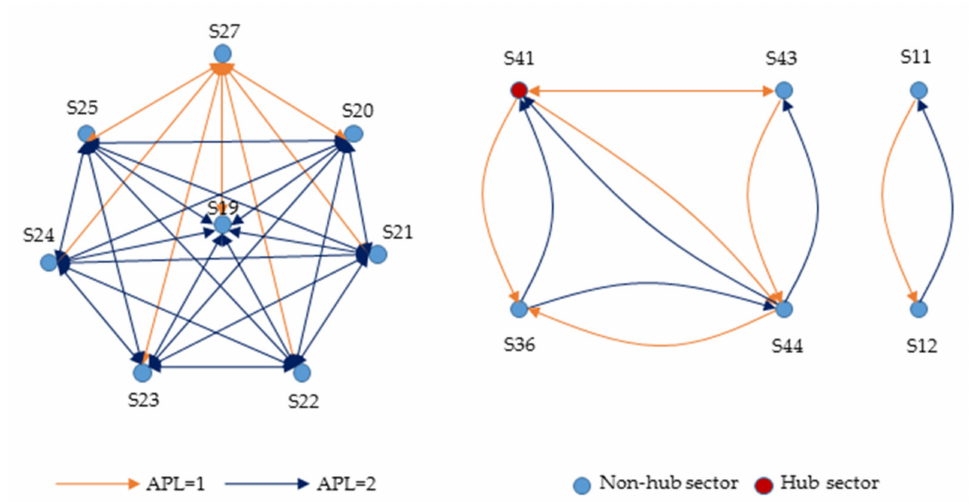
Figure 2. The hub wastewater propagation chains that APL-HCG selected in 2007. The orange and dark blue edges mean that their APL value is 1 and 2, respectively. Each vertex in figures represents a sector explained in Appendix B. Dark red nodes indicate sectors that densely surround many linkages with a considerable degree of closeness to their linked sectors. The blue nodes imply that there are no surrounding dense linkages in the results.